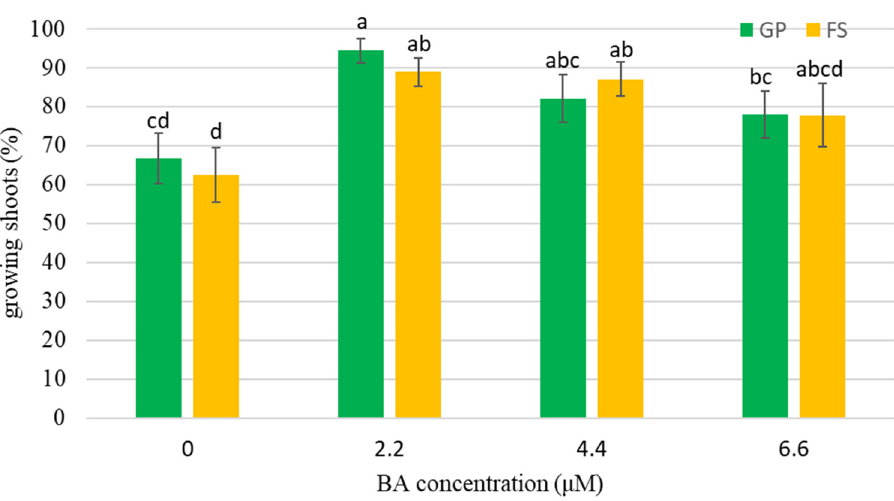
Figure 3. The frequency of growing shoot apices taken from greenhouse plants (GP; green) and field sprouts (FS; orange) shoots of bigleaf maple to three concentrations of BA in DKW basal medium. Total number of tested shoot apices from left to right: 54, 48, 54, 72, 39, 62, 50, 27. Error bars represent standard error. Medium with 2.2 or 4.4 μ M BA resulted in significantly higher frequency of growing shoots than medium without BA, as indicated by different letters above bars (two-way ANOVA and Fishers LSD, p < 0.05).